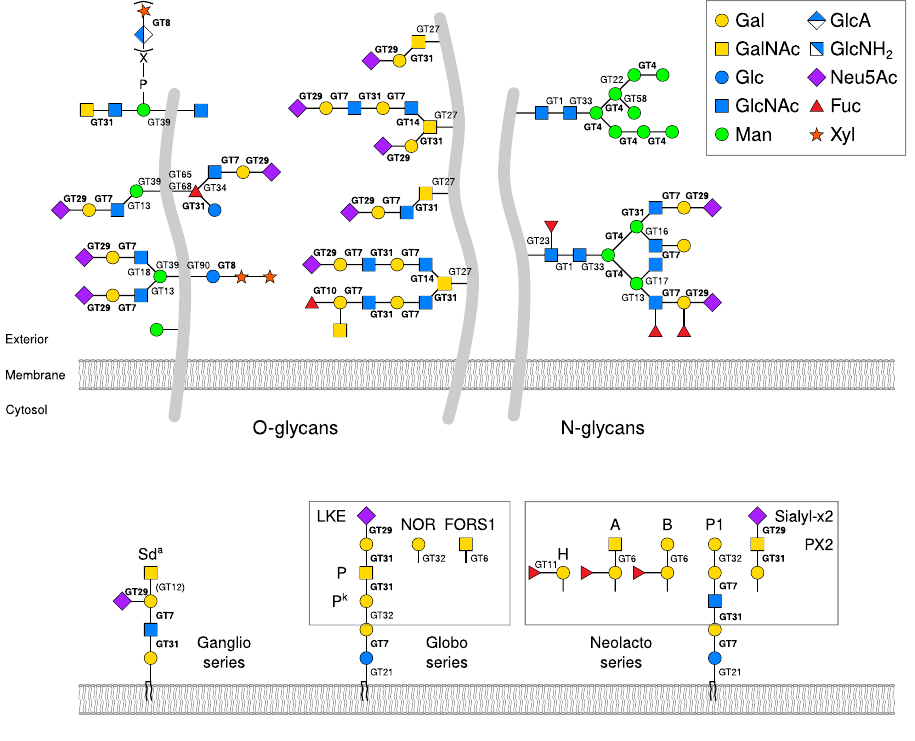
Figure 5. Selected glycan types expressed on RBCs, including some known blood group antigens. We determined a set of genes expressed in RBCs and with predicted benign impact (Table 2). The disruption of these genes could potentially lead to alterations in cell surface antigens and incompatibility in transfusion and transplantation. Models of a selected subset of O- and N-glycans and glycosphingolipids with predicted expression on the RBC surface are shown. Indicated are the GT families that are present in the list of GTs expressed in RBCs (Supplementary Table 2). Furthermore, the GT families highlighted in bold font all have members listed as candidate genes in Table 2. Names of known glycan blood group antigens are indicated. Sialyl-x2 is a suggested but not yet officially acknowledged blood group 40 . The Sd a , A, B, and H antigens are known to be expressed also on glycoproteins but are shown here only on glycosphingolipids for reasons of graphic clarity. This figure was modified and updated from Hansen et al . 13